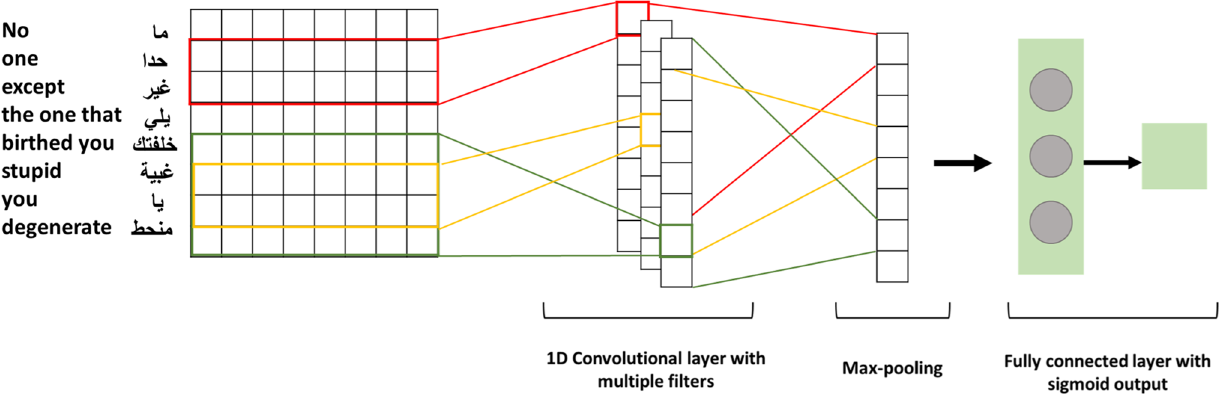
Fig. 4 Convolutional neural network